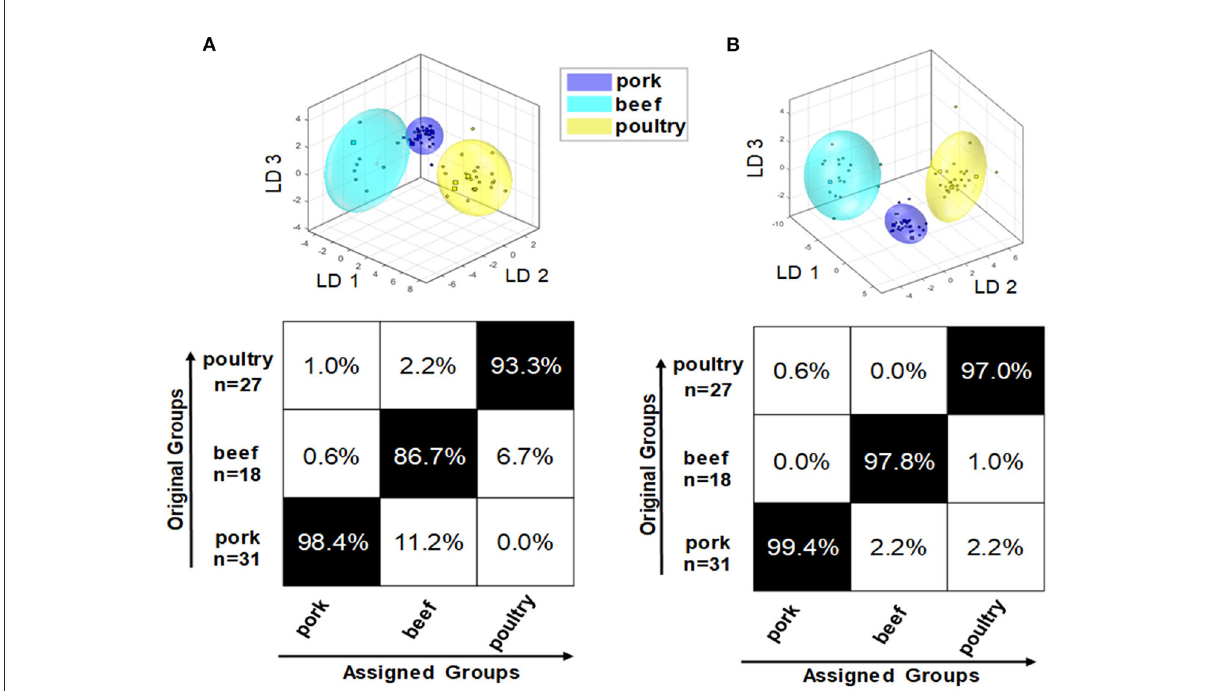
FIGURE7 Results of embedded MCCV on the obtained classification model of PCA/LDA to predict the species of processed meat products via the 1 H NMR spectra of the polar metabolites (A) as well as after mid-level data fusion (B) .